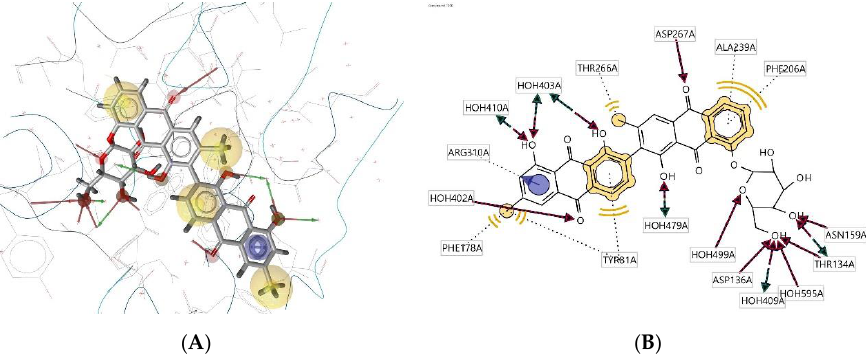
Figure 10. Ligand 100D interacts with the macromolecule. ( A ) 3D view of pharmacophore at the macromolecule binding site. ( B ) 2D view of pharmacophore. Pharmacophore features: hydrophobic interactions (H), yellow; hydrogen bond acceptor (HBA), red; hydrogen bond donor (HBD), green; aromatic (AR) interaction, purple. Ligand 298D interacts with the macromolecule, as shown in Figure 11A,B. It shows hydrophobic interactions with amino acids Val78A, Thr266A, Val268A, Phe206A, Thr134A, Tyr210A, Ile211A, Phe178A, Trp82A, and Tyr81A. This pharmacophore also has a hydrogen bond acceptor (HBA) feature with nearby water molecules and amino acid residues Ser265A and Val268A. Looking at the hydrogen bond donor (HBD) feature, the ligand only interacts with nearby water molecules. An additional feature, positive ionisa- ble area (PI), shows interactions with Asp136A and Asp267A. Based on the interactions, this structure provides a pharmacophore with four pharmacophore features: hydrophobic interactions (H), hydrogen bond acceptor (HBA), hydrogen bond donor (HBD), and pos- itive ionisable area (PI).